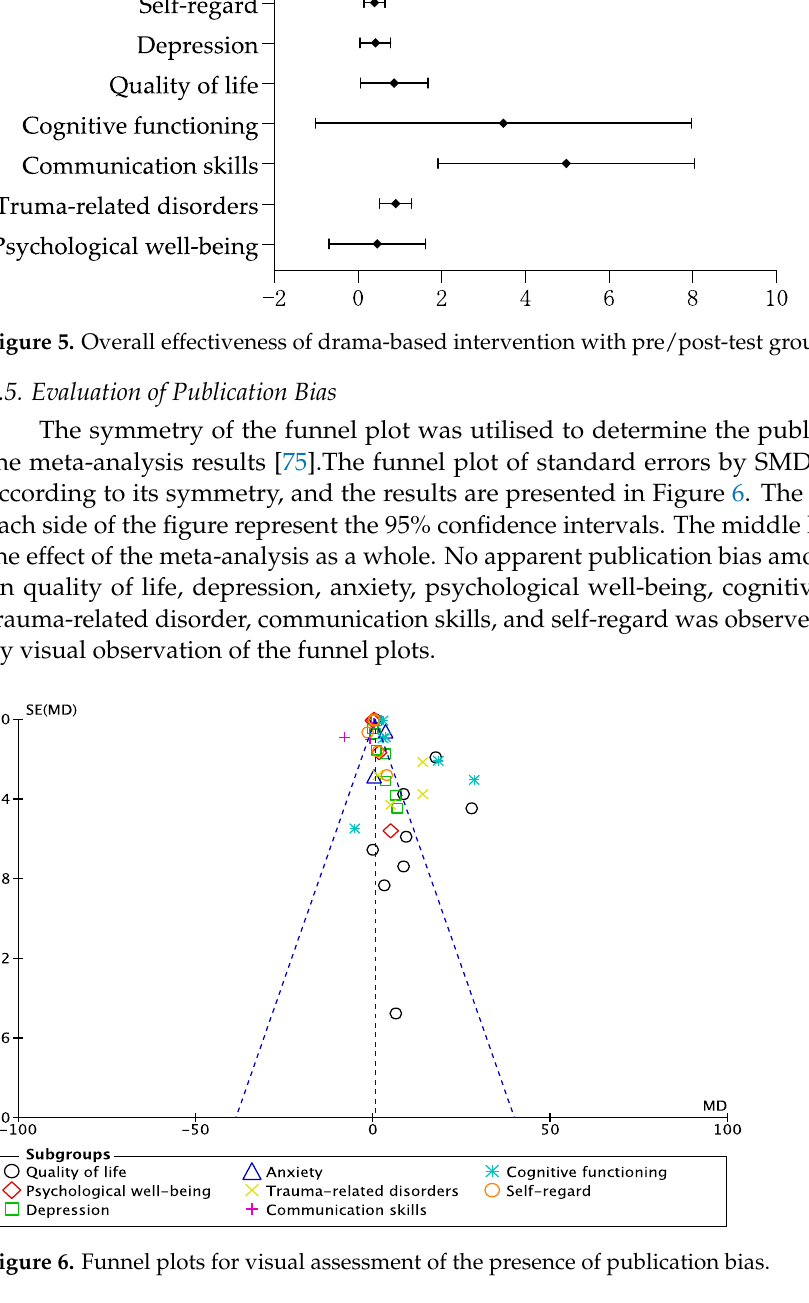
Figure 6. Funnel plots for visual assessment of the presence of publication bias.